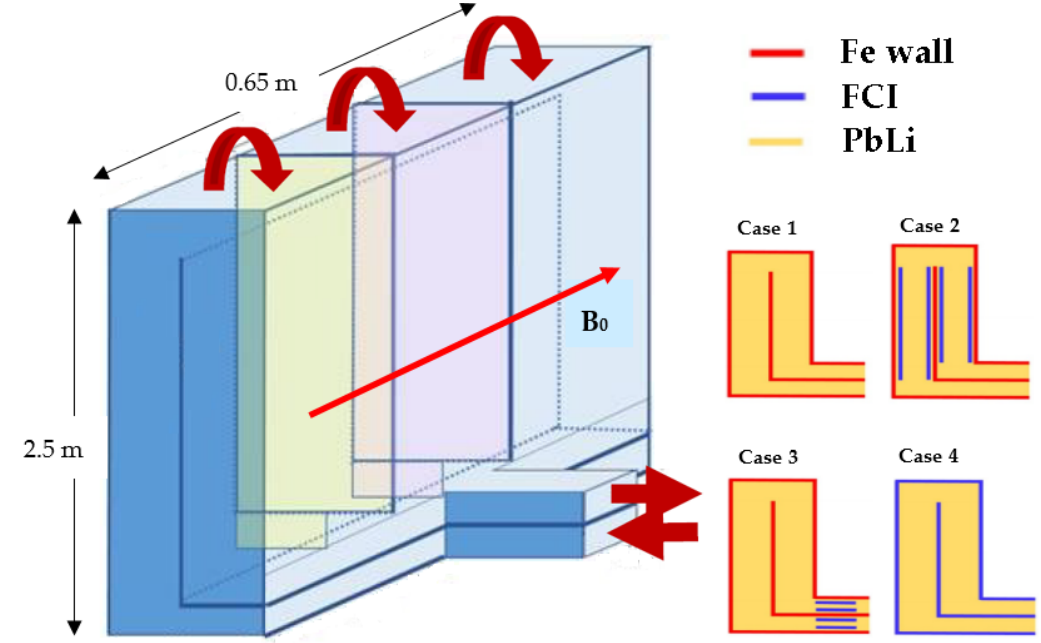
Figure 17. The PbLi blanket prototype with radial supply ducts, inlet and outlet manifolds, poloidal channels and a U-turn section at the top [67]. Four cases of electrical insulation 1–4 have been considered.